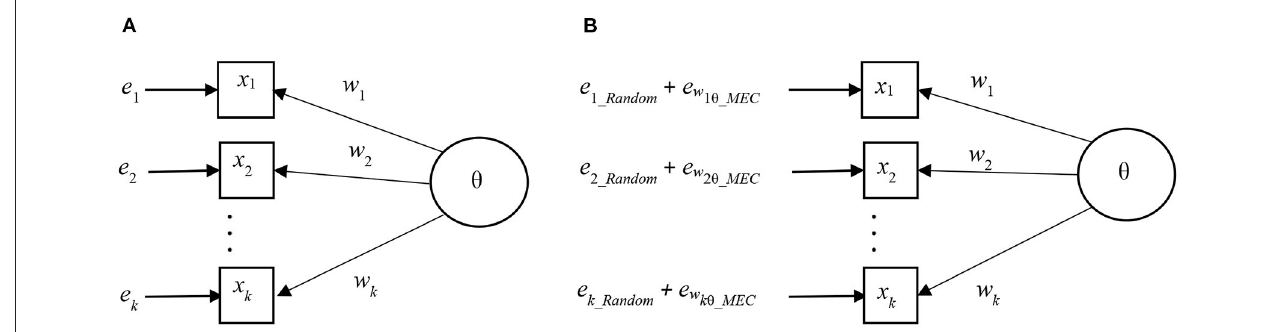
FIGURE 2 | Measurement models without and with elements of MEC. (A) Traditional measurement model. (B) Measurement model including elements of